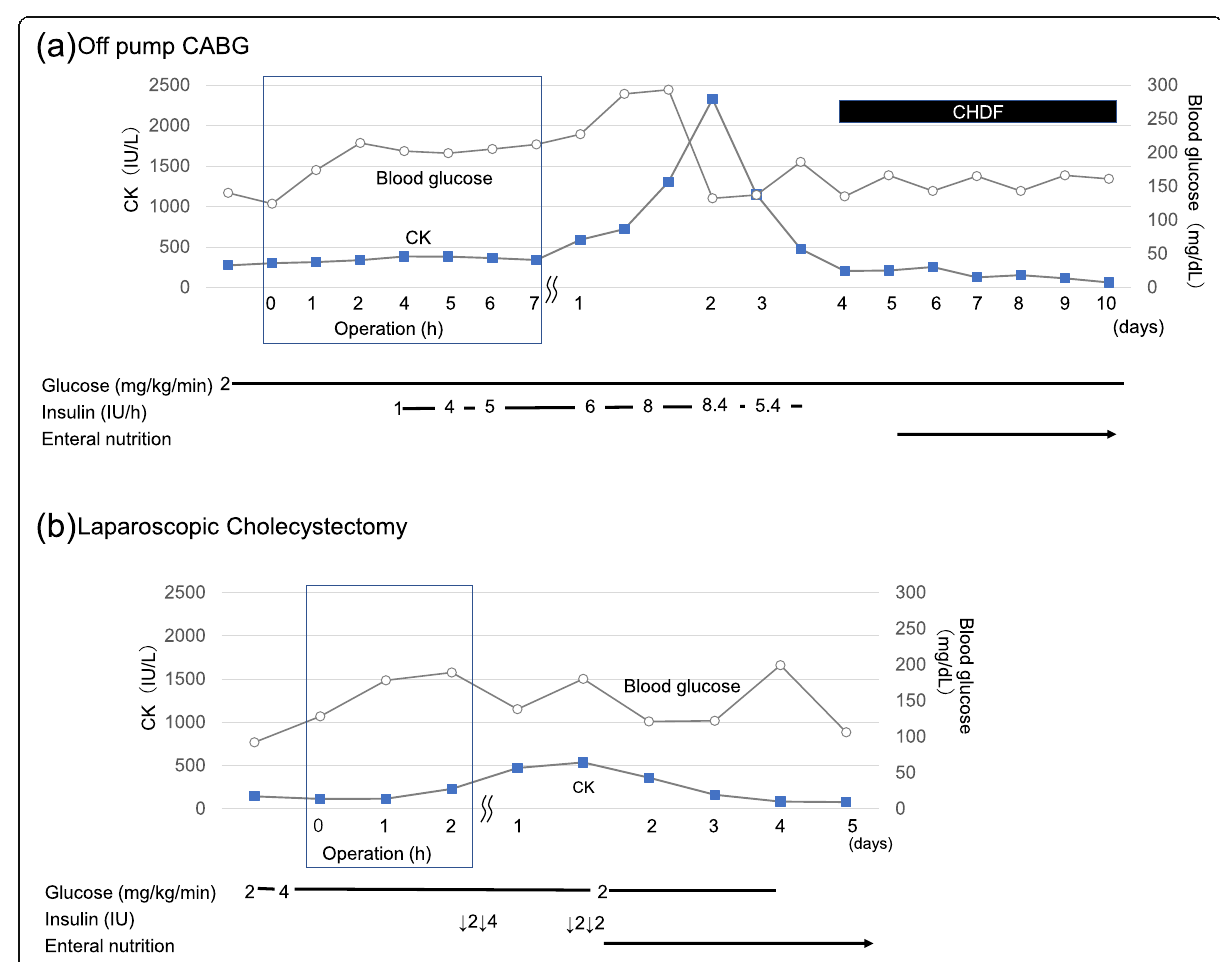
Fig. 1 a Perioperative blood CK and glucose levels during off-pump CABG. The CK levels increased to a maximum value of 2328 U/L on POD 2. Insulin administration was initiated when the blood glucose levels exceeded 200 mg/dL and continued until POD 3. CHDF was performed between PODs 4 and 25. b Perioperative blood CK and glucose levels during laparoscopic cholecystectomy. The CK levels slightly increased on PODs 2 and 3 with a continuous glucose infusion rate of 4 mg/kg/h and intermittent administration of intravenous insulin; however, there was no acute renal failure. CK, creatine kinase; CABG, coronary artery bypass grafting; POD, postoperative day; CHDF, continuous